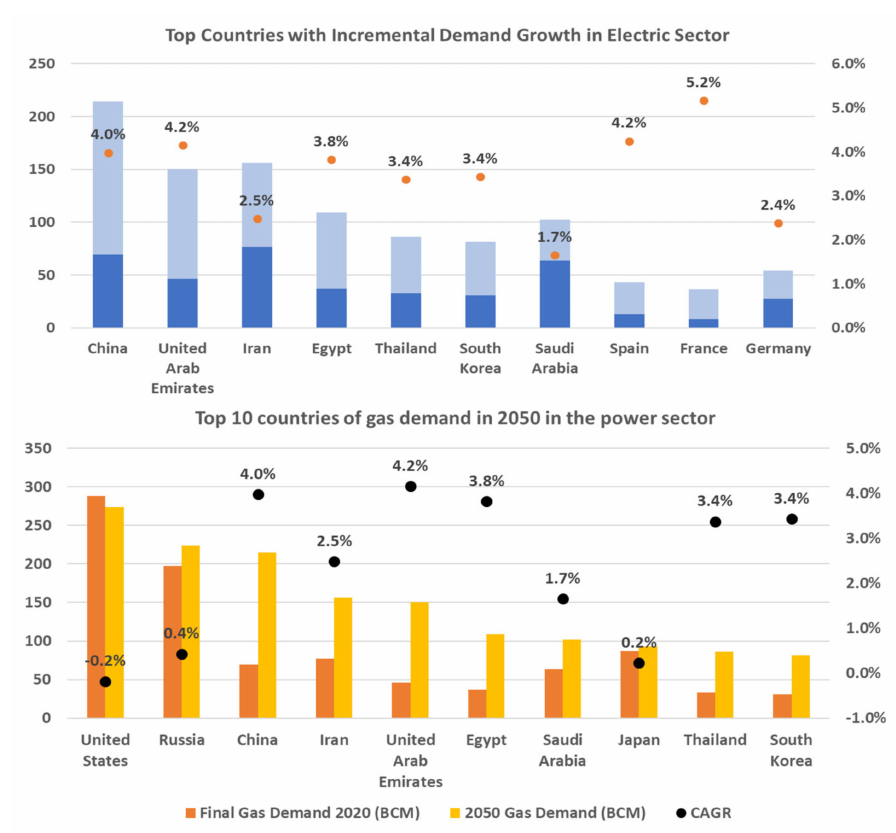
Figure 16. (Two panels) Top 10 countries of gas demand growth in the electric sector and demand volume in 2050 (demand volumes in BCM on first axis, and % growth on secondary